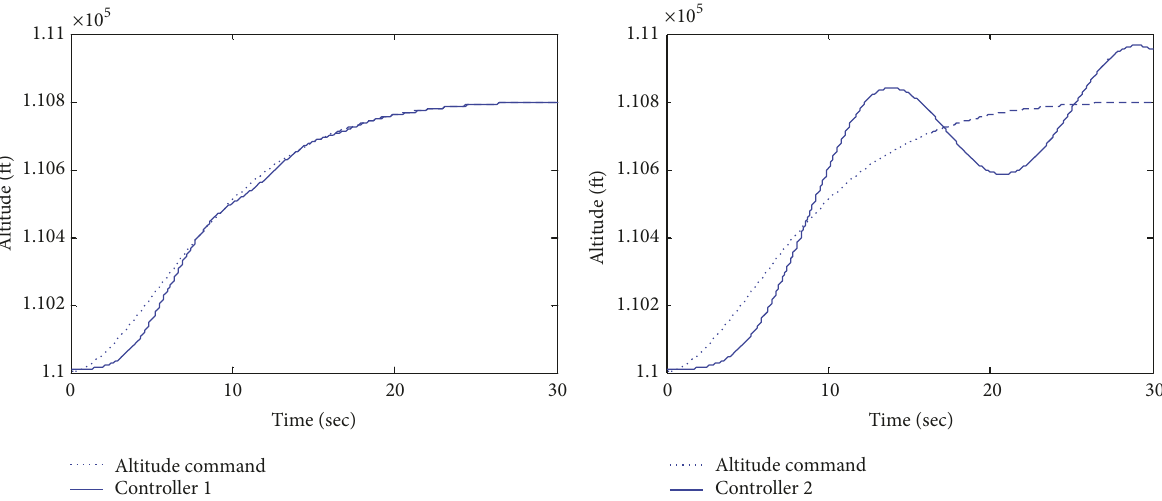
Figure 2: Altitude tracking trajectories using different design